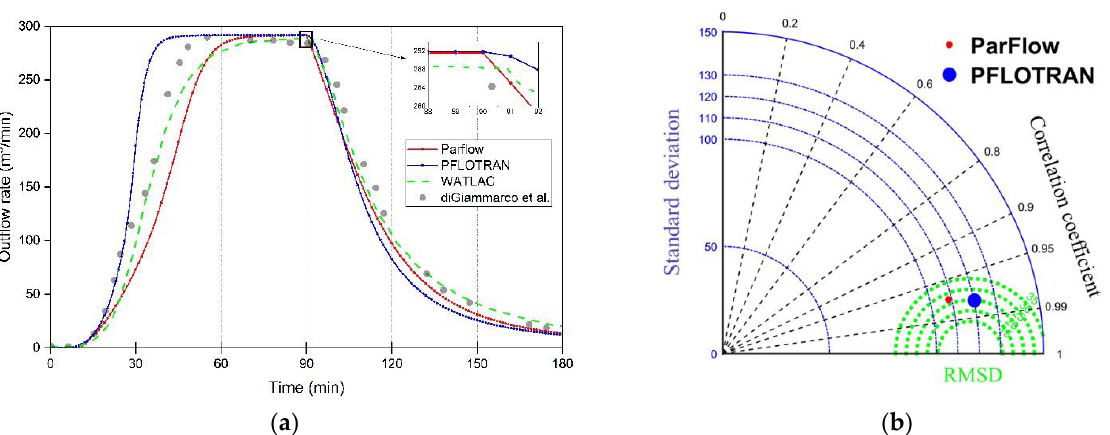
Figure 11. Outflow response comparison among ParFlow, PFLOTRAN, WATLAC and Di Giammarco et al. [47,48] for 2D tilted V-catchment case: ( a ) Time-series comparison plots. 5% error of analytical solution is drawn in gray as well; ( b ) Taylor diagram for ParFlow and PFLOTRAN, including SD, R, RMSD and normalized computational efficiency (the smaller size, the higher efficiency).